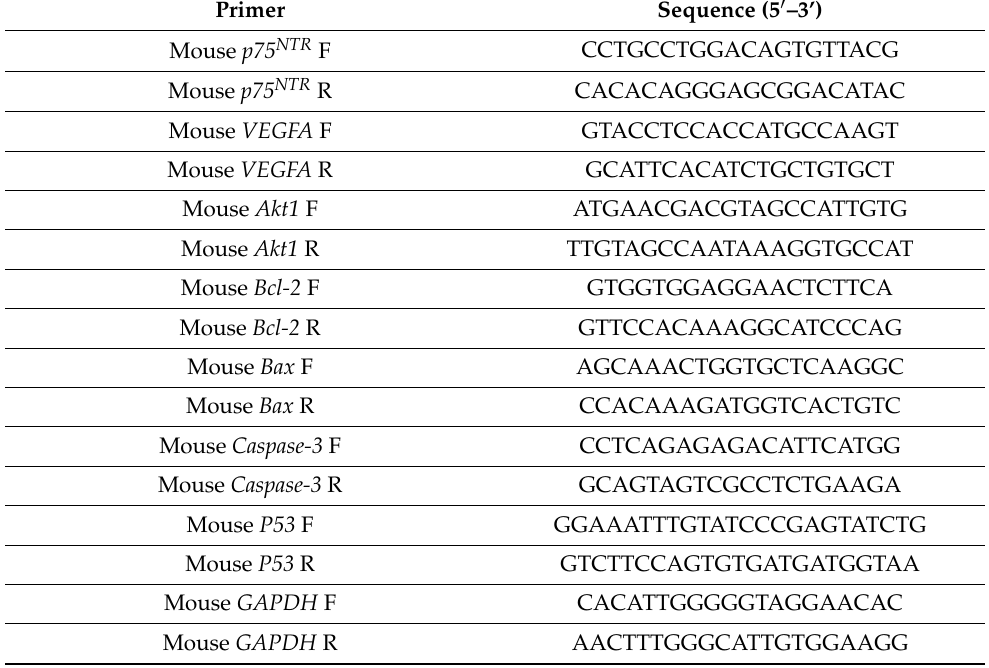
Table 1. The sequence of the PCR primers used in the mRNA quantification experiments. Primer Sequence (5 (cid:48)